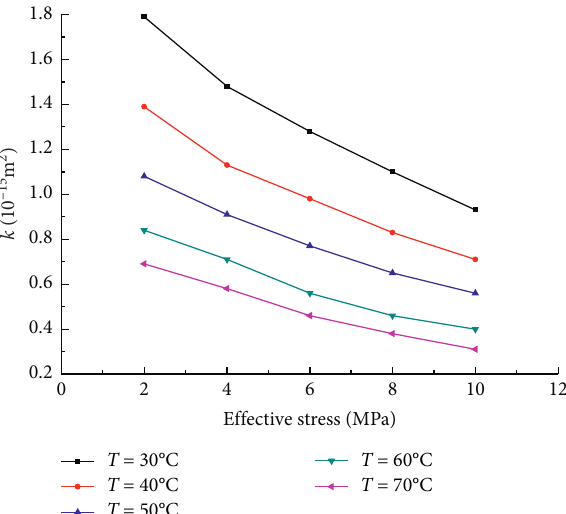
Figure 4: Percolation rate of coal with effective pressure under different temperatures at the gas pressure of